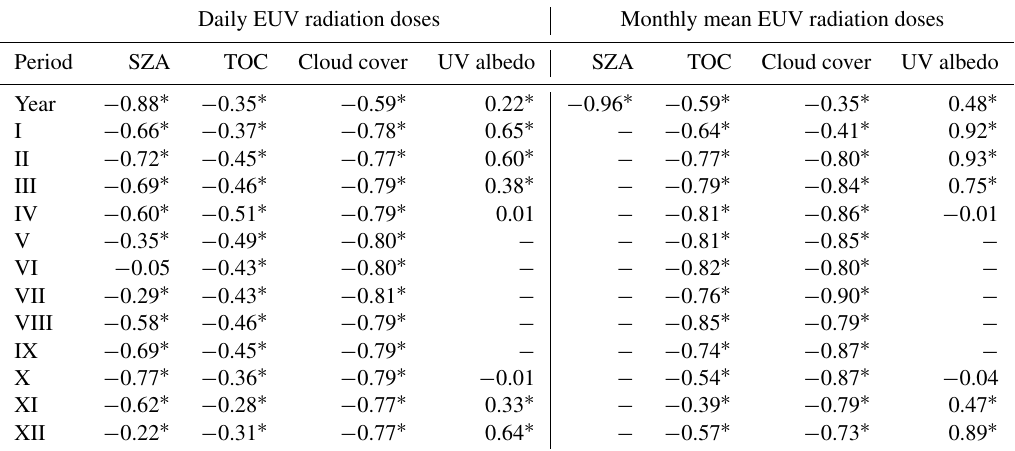
Table 5. Partial correlation coefficients of the effect of SZA, TOC, cloud cover, and UV albedo on EUV radiation daily doses and their monthly means throughout the period 1964–2013; asterisks mark statistically significant correlations ( α = 0.05).